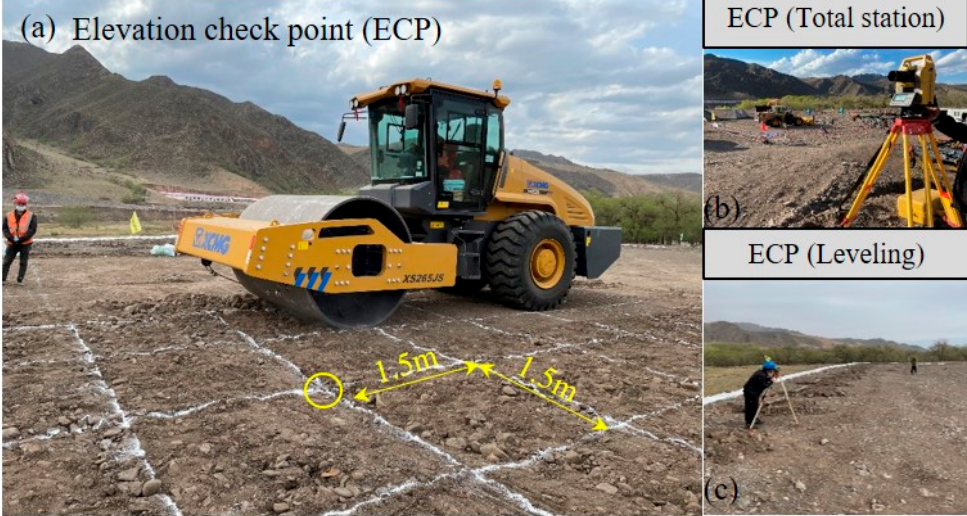
Figure 7. ECP measurement: ( a ) Distribution of ECP; ( b ) ECP measured by total station; and ( c ) ECP measured by level survey.